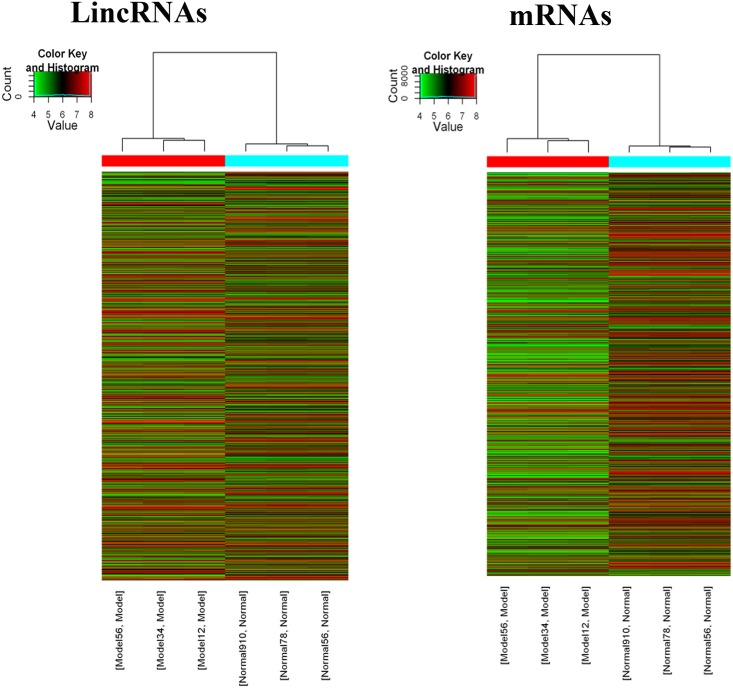
Hierarchical clustering of lncRNA and mRNA by Z-score.Based on the expression levels of (A) lncRNAs or (B) mRNAs, the six samples were classified into two groups (sperm from diabetic or control mice). The dendrogram shows the relationships among the expression levels of samples. Red indicates high relative expression, and green indicates low relative expression.